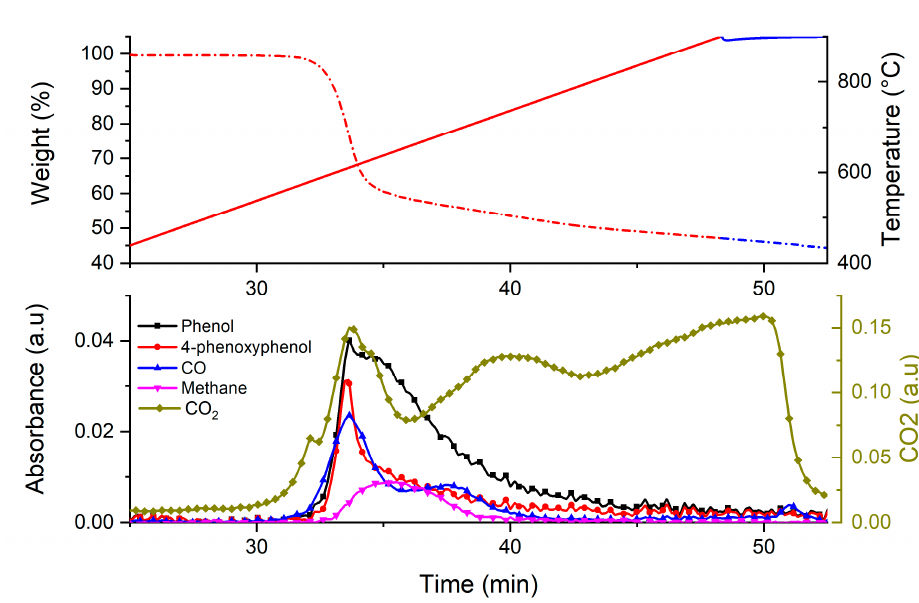
Figure 7. TGA plot ( top ) of PEEK at 2% O 2 at heating rate 20 °C/min and peak intensity profiles ( bottom ) corresponding to gases evolved during the TGA measurement.